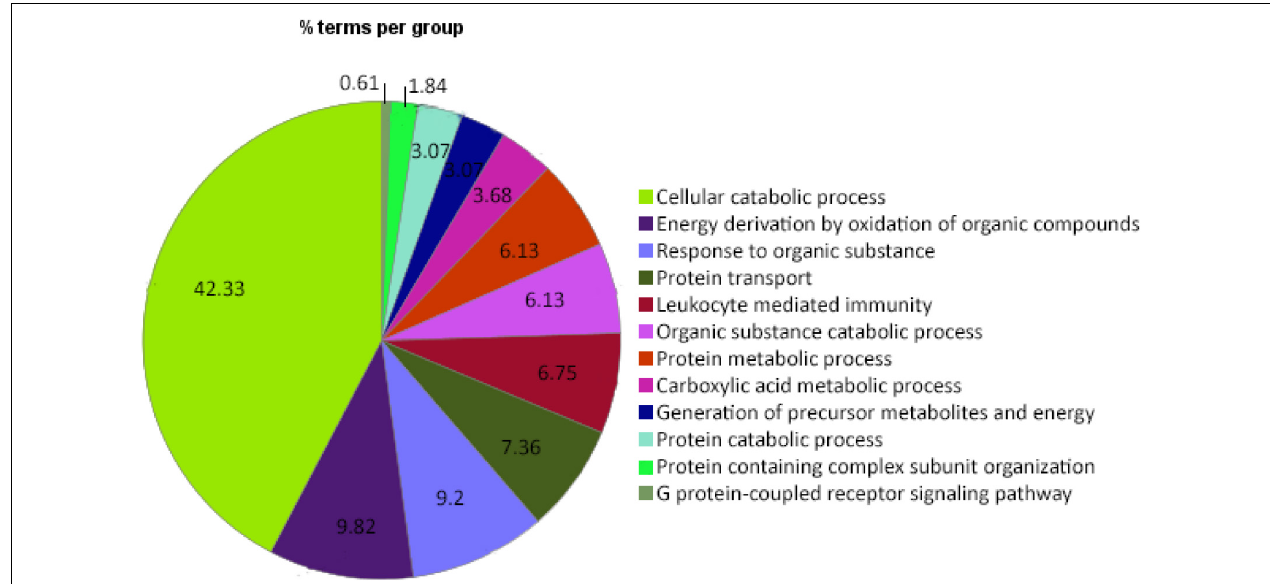
FIGURE 4 | Pie chart distribution of significantly enriched terms based on the biological functions in the anterior intestine of gilthead sea bream fed the SDPP diet. It is represented the percentage of the significantly differentially expressed genes in each principal